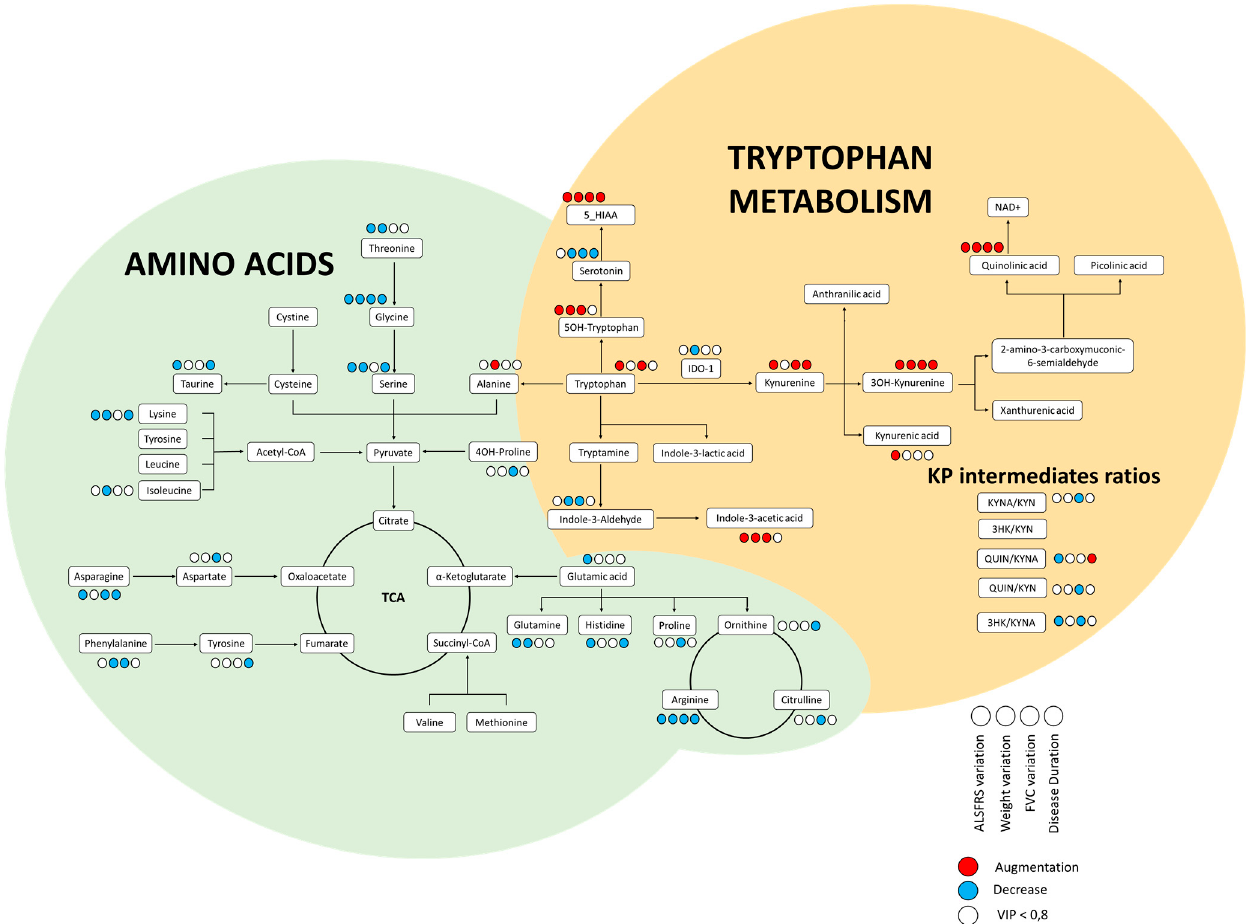
Figure 1. Metabolic pathway explored in this work. Colored dots are present only when the metabolite had a VIP value > 0.8 for one of the following parameters: ALSFRS variation (first dot), weight loss (second dot), FVC over year (third dot), survival (fourth doth). A blue dot indicates a decrease of the feature and a red dot an increase. TCA: Tricarboxylic acids.